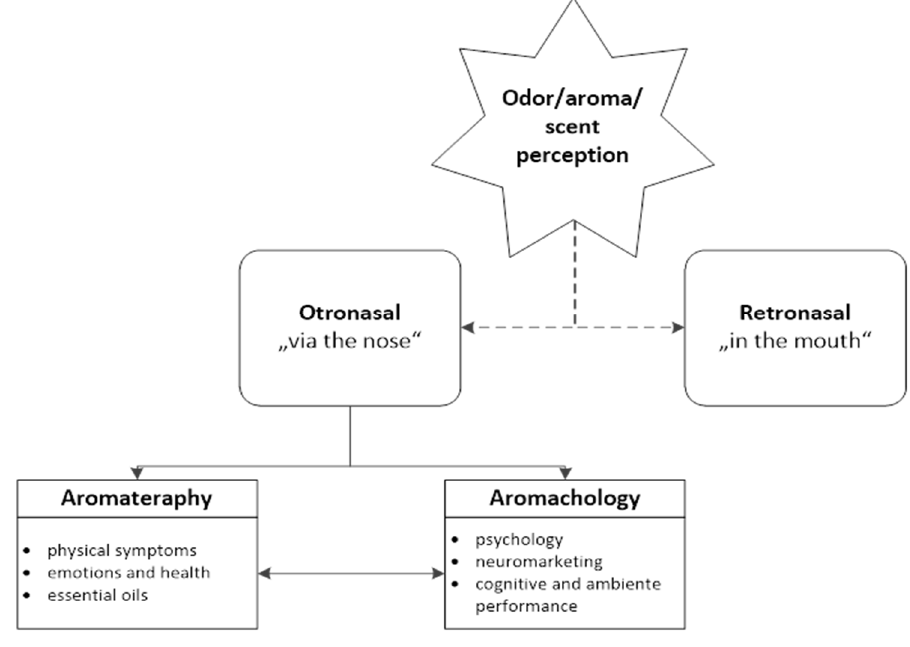
Figure 1. Human perception of aroma. Table 1. Differences between Aromatherapy and